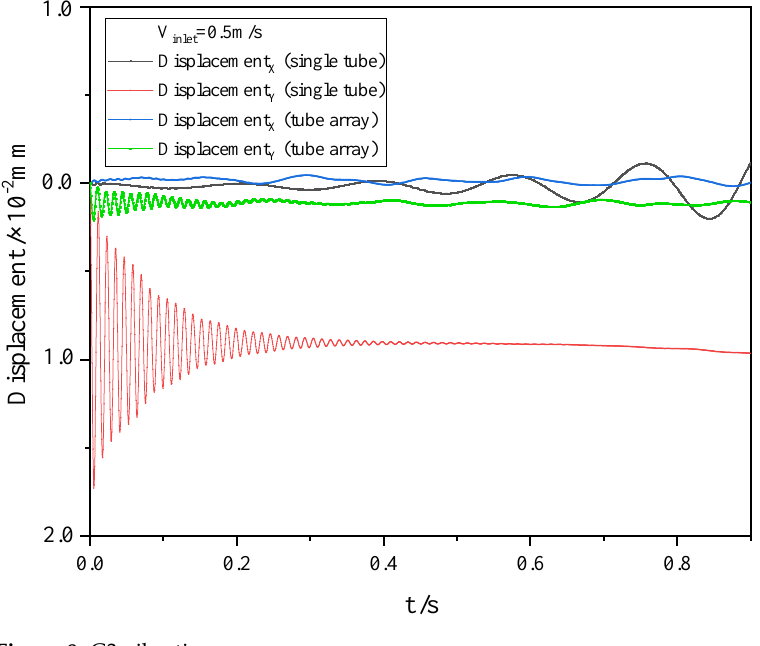
Figure 7. Single helical tube calculation model and grid division.